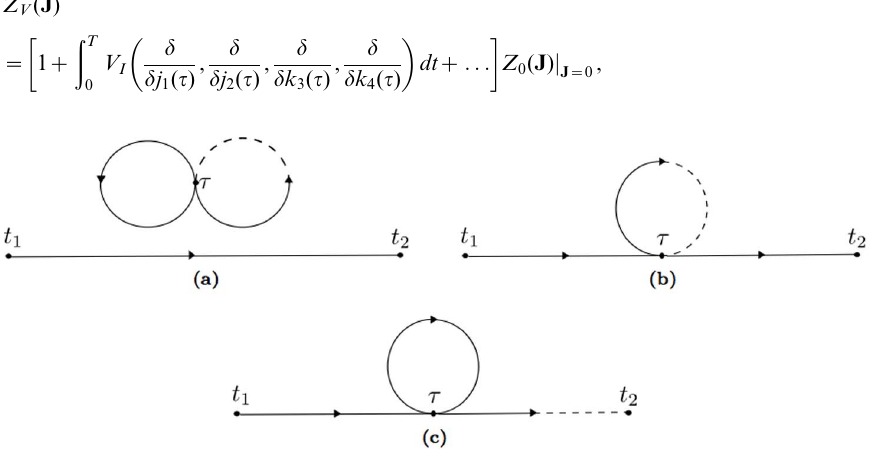
Figure 8. The terms of the perturbation expansion for the 2-point correlation, the variance. The full contribution can be obtained by using symmetry over all the vertices and adding the graphs obtained exchanging 2 with 4: (a) disconnected graph, corresponding to (61), (b) graph with G 24 integrated over the internal vertex t , corresponding to (62), (c) graph with G 24 into an external point corresponding to (63).